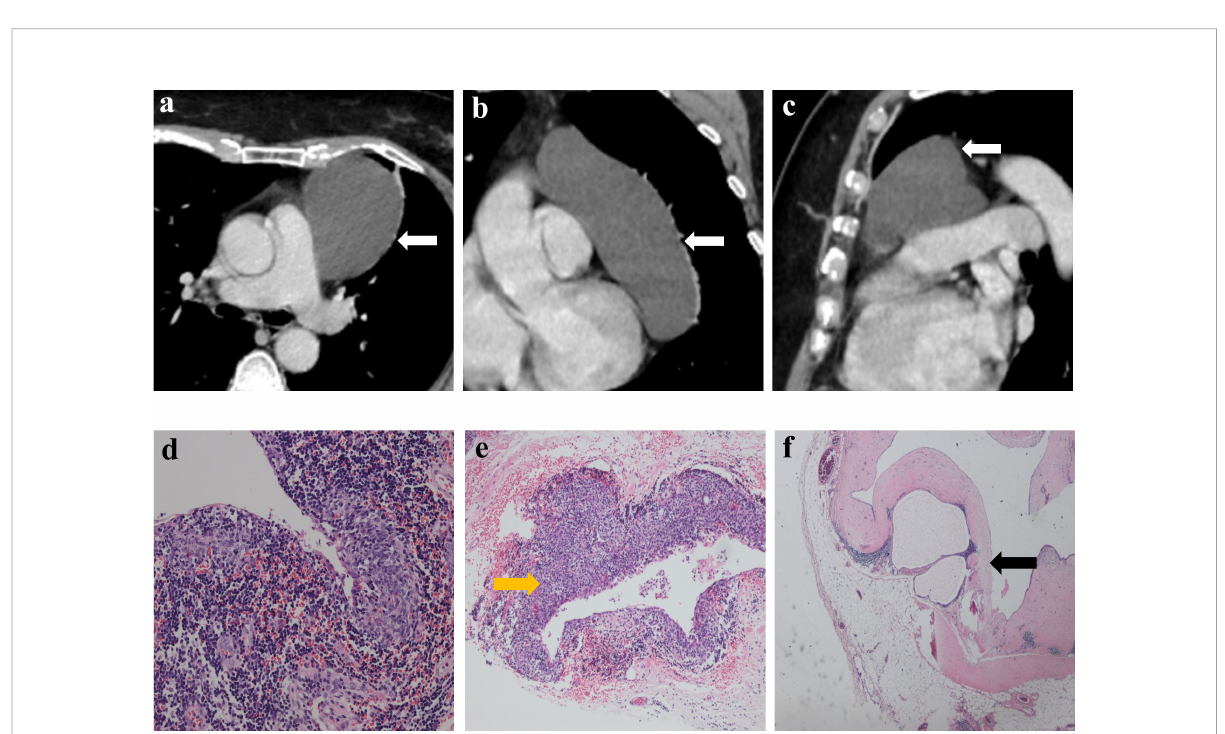
FIGURE 2 Imaging and histologic fi ndings of a 55-year-old woman with primary mediastinal MTWLS (case 1). (A) Axial, (B) coronal and (C) sagittal chest CT images with contrast enhancement reveal a 7.6×5.9×12.2-cm purely cystic and round or oval left anterior mediastinal mass (white arrow) adjacent to the mediastinum pleura, pericardium and large blood vessels. (D) Hematoxylin-eosin (H-E) – stained section of the mass reveals spindle cells forming multiple micronodules separated by abundant interstitial lymphocytes. (E) Some cyst walls (yellow arrow) were covered with nodular tumors (F) and other cyst walls were covered with a single layer of epithelioid cells (black